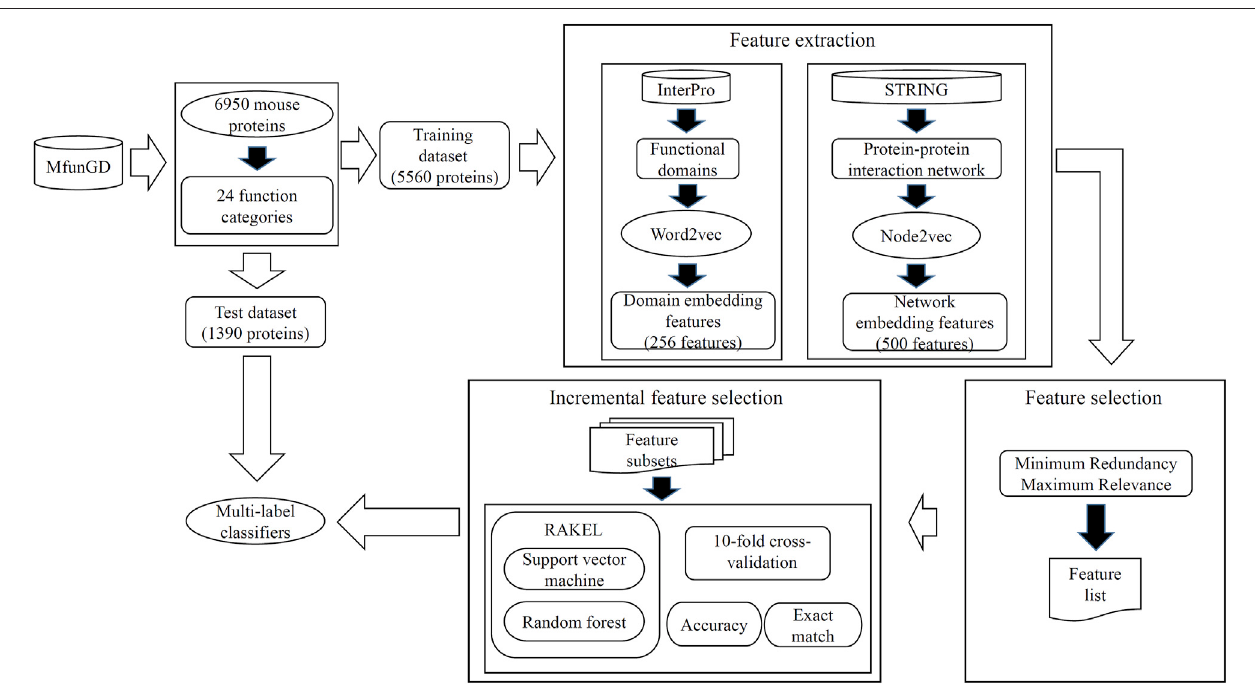
FIGURE 2 | Entire procedures to construct the multi-label classi fi ers for predicting functions of mouse proteins. Mouse proteins and their function annotations are retrieved from MfunGD. These proteins are randomly divided into one training dataset and one test dataset. Embedding features were derived from protein functional domainsand protein – protein interaction network through Word2vec and Node2vec, respectively. A featureselection procedure is used to analyze embedding features, and essential features are fed into RAKEL to construct the multi-label classi fi ers. Proteins in the test dataset are fed into these classi fi ers to further evaluate their